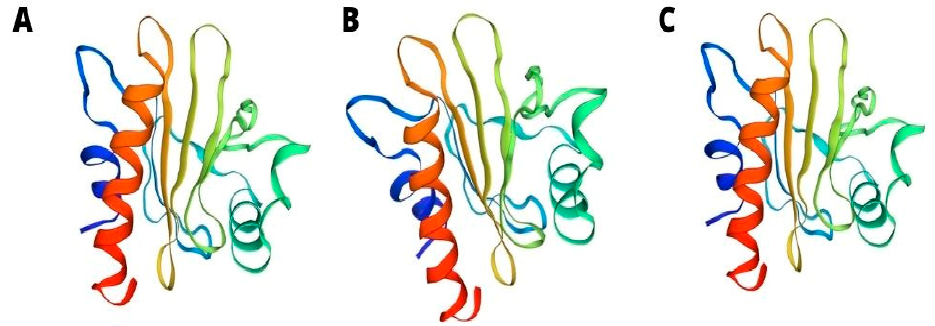
Figure 2. 3D structure of tomato Sola l 1 ( A ) Latex Hev b 8 ( B ) and apple Mal d 4 ( C ).